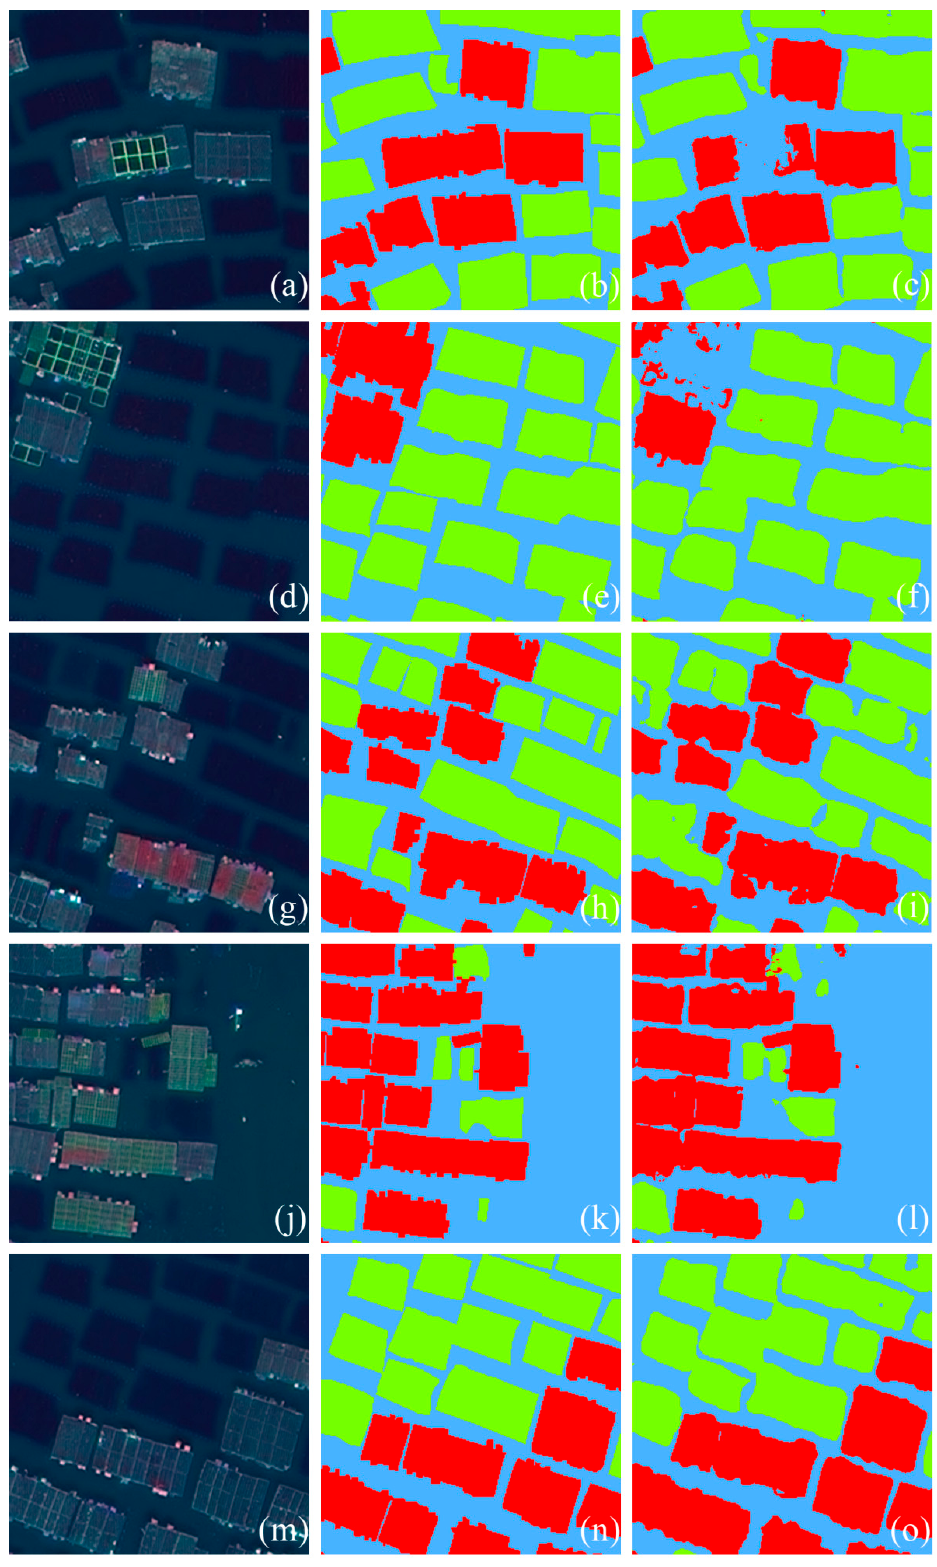
Figure 20. The local images, labels and extraction results of test C. ( a , d , g , j , m ) Local images. ( b , e , h , k , n ) Labels. ( c , f , i , l , o ) Extraction results of U-Net experiment 5.